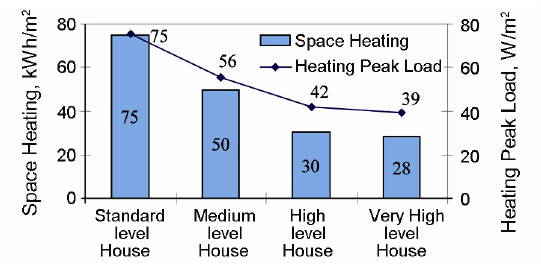
Fig. 8. The change in peak load and space heating demand for the different types of houses